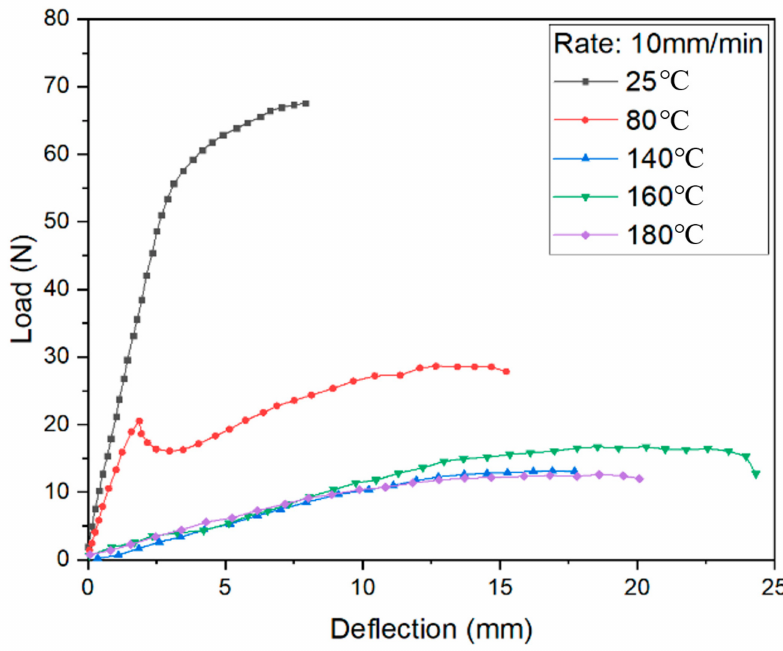
Figure 9. Load-displacement curves and fitting surface under 10 mm/min loading rate.